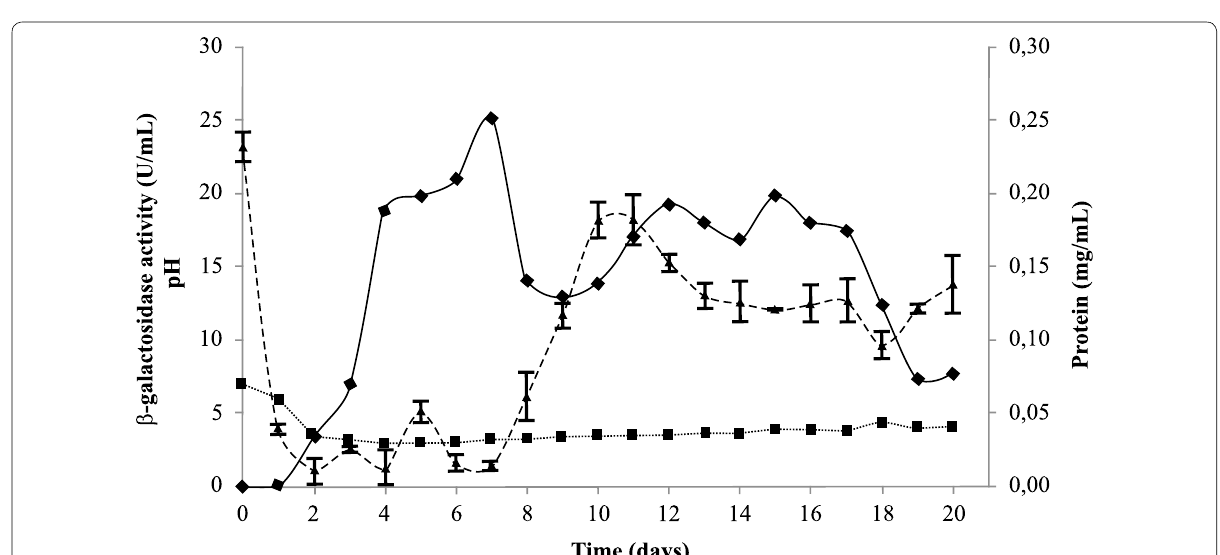
Fig. 3 Time courses of β‑galactosidase production by Aspergillus niger under optimized conditions (120 rpm, 28 °C, initial medium pH 7), using medium supplemented with 2% of soybean residue. Medium pH (∙∙∙∙), protein (mg/mL) (‑‑‑) and β‑galactosidase activity